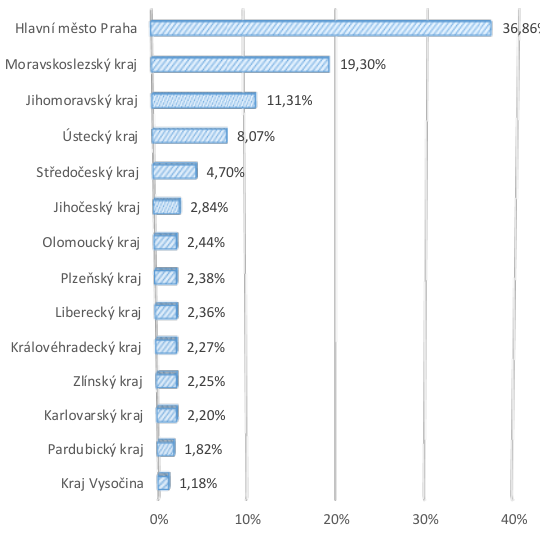
Graf 5: Struktura cenových nabídek podle kraje - počet nabídek bytů k pronájmu (zdroj: autor)